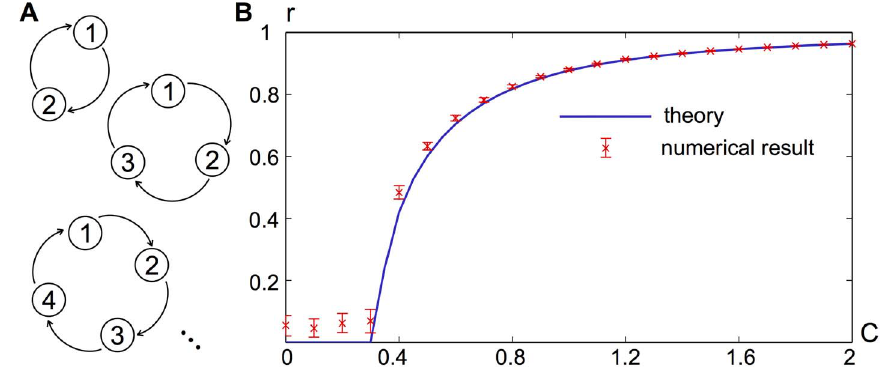
Figure 6. The order parameter on a cycle. A : Illustration of cycles with increasing number of nodes. B : A plot of analytical and numerical results of the order parameter on a cycle of 3 nodes. The numerical example is obtained for 10 3 oscillators per